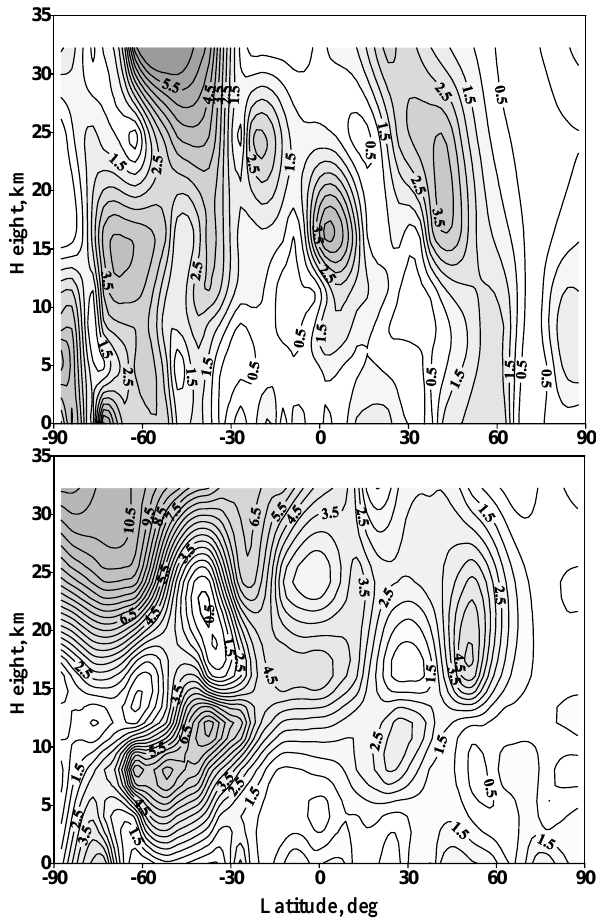
Fig. 5. Ratio of linear rate absolute values to the corresponding standard deviations for zonal wind (upper panel) and temperature (lower